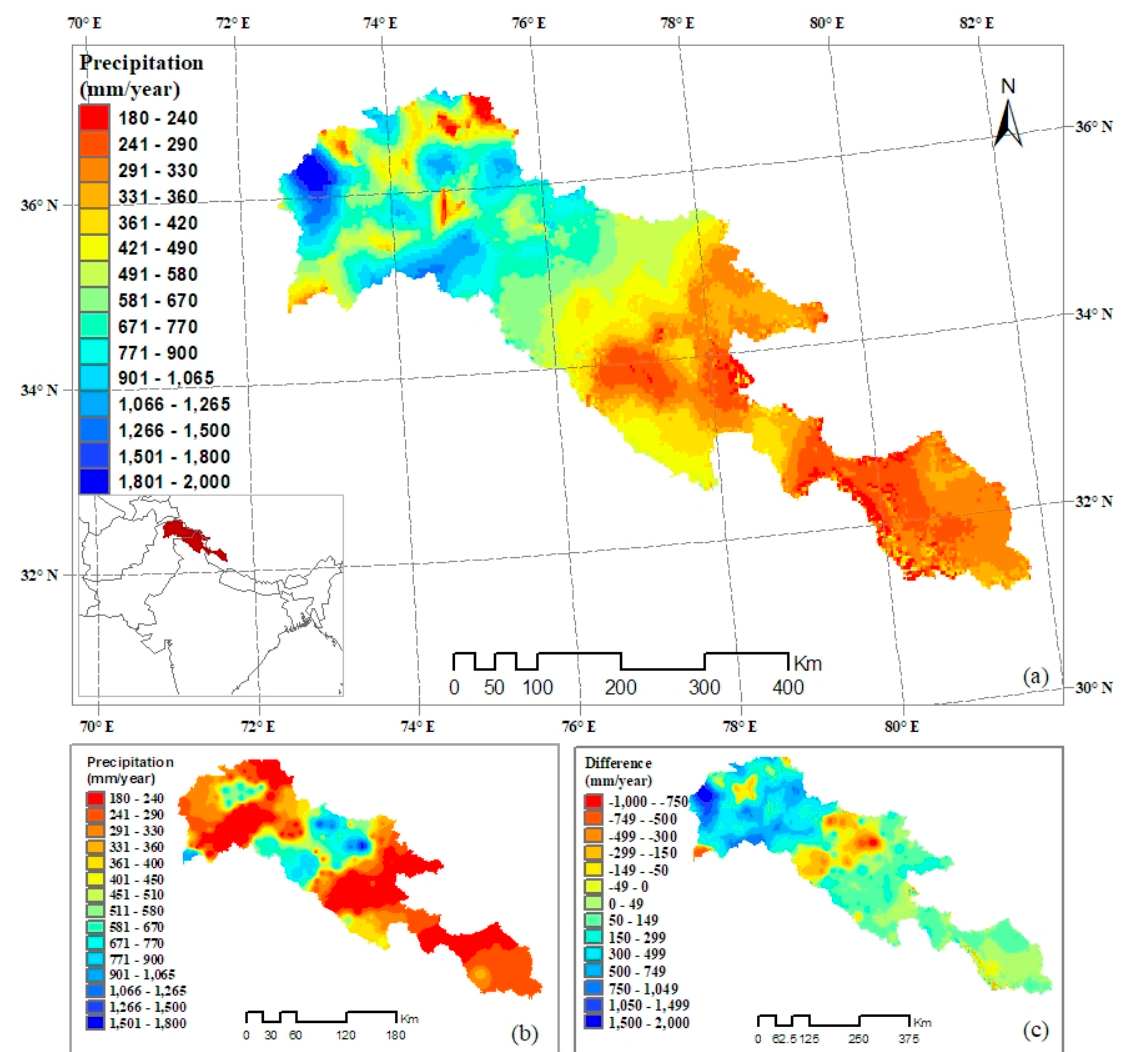
Figure 3. Generated gridded climate data set (1999–2008) for the UIB: ( a ) mean annual regionalized precipitation (mm), ( b ) mean annual observed precipitation (mm), ( c ) difference between regionalized and observed precipitation (mm).